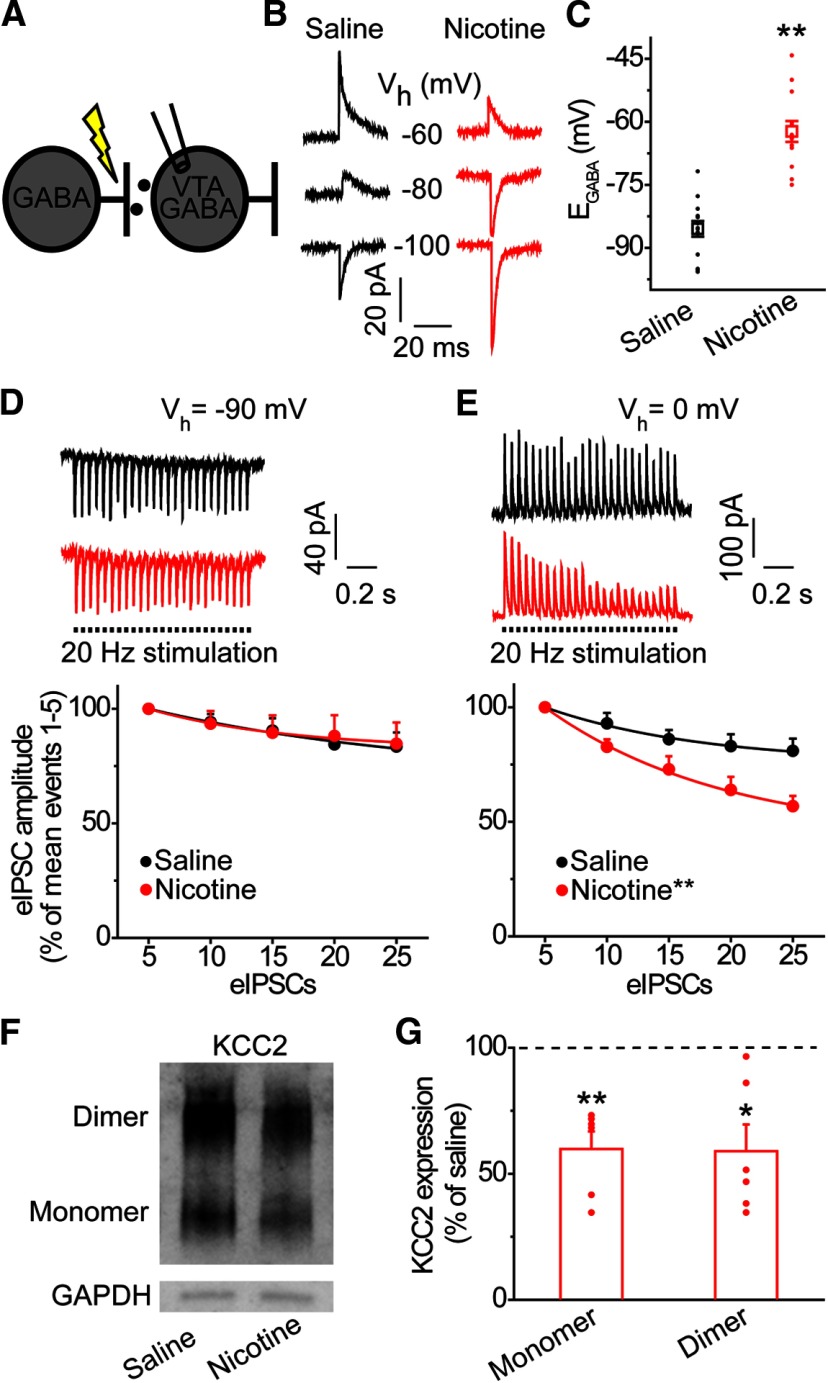
Acute nicotine exposure alters Cl− homeostasis in the VTA. A, GABAergic input onto VTA GABA neurons was measured using gramicidin perforated-patch whole-cell recordings at different holding potentials to measure nicotine-induced alterations in anion homeostasis. GABAA IPSCs were evoked by electrical stimulation in the presence of ionotropic glutamate and GABAB receptor antagonists. B, Representative eIPSC recordings from saline (black) and nicotine (red)-treated animals at the given holding potentials (Vh). The eIPSCs reverse direction at EGABA. For display, the traces were filtered, and stimulus artifacts were removed. C, VTA GABA neurons from nicotine-treated animals (red) showed a significantly more positive EGABA compared with saline-treated animals (black); **p < 0.01, significantly different by t test, n = 13, n = 14 cells/group, n = 7 rats/group. D, Activity-dependent synaptic depression in VTA GABA neurons was measured during whole-cell patch clamp recordings under repetitive GABAAR stimulation. Traces on top: representative GABA neurons from saline (black) and nicotine-treated rats (red) demonstrated a similar depression in eIPSC amplitude when stimulated at 20 Hz and clamped at −90 mV. Bottom graph, At −90 mV, VTA GABA neurons from control and stressed animals showed no significant difference in rate of eIPSC amplitude depression (p > 0.05, n = 8 cells, n = 4 rats for the nicotine group and n = 16 cells, n = 6 rats for the saline group). Amplitude values were averaged for five eIPSCs and shown as a percent of the first five eIPSCs mean amplitude. E, Cl− accumulation was measured as in D, but VTA GABA neurons were clamped at 0 mV. Top traces, Upon stimulation, VTA GABA neuron from control animal (black) demonstrated a minor depression of eIPSC amplitude compared with the significantly greater depression seen in a GABA neuron from a stressed animal (red). Bottom graph, At 0 mV, GABA neurons from nicotine treated animals (red) demonstrated a significantly greater rate of eIPSC amplitude depression than GABA neurons from saline-treated animals (black); **p < 0.01, significantly different by ANOVA with repeated measures, n = 8 cells, n = 4 rats for the nicotine group and n = 16 cells, n = 6 rats for the saline group. F, Western blot analysis was conducted for KCC2 protein expression with GAPDH as a loading control. A representative Western blotting shows reduced expression of KCC2 in nicotine-treated animals. G, Densiometric analysis showed a significant reduction in KCC2 protein in nicotine-treated animals (red bars) compared with saline-treated controls (horizontal dashed line); *p < 0.05, **p < 0.01, significantly different by paired t test, n = 6 animals/group.